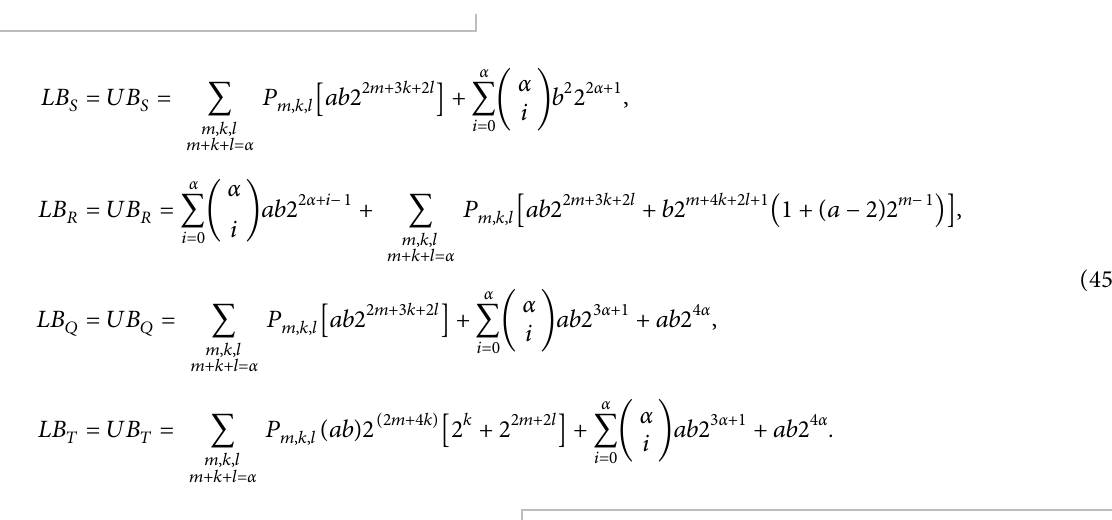
Table 6: Few more cases of lower and upper bounds regarding R